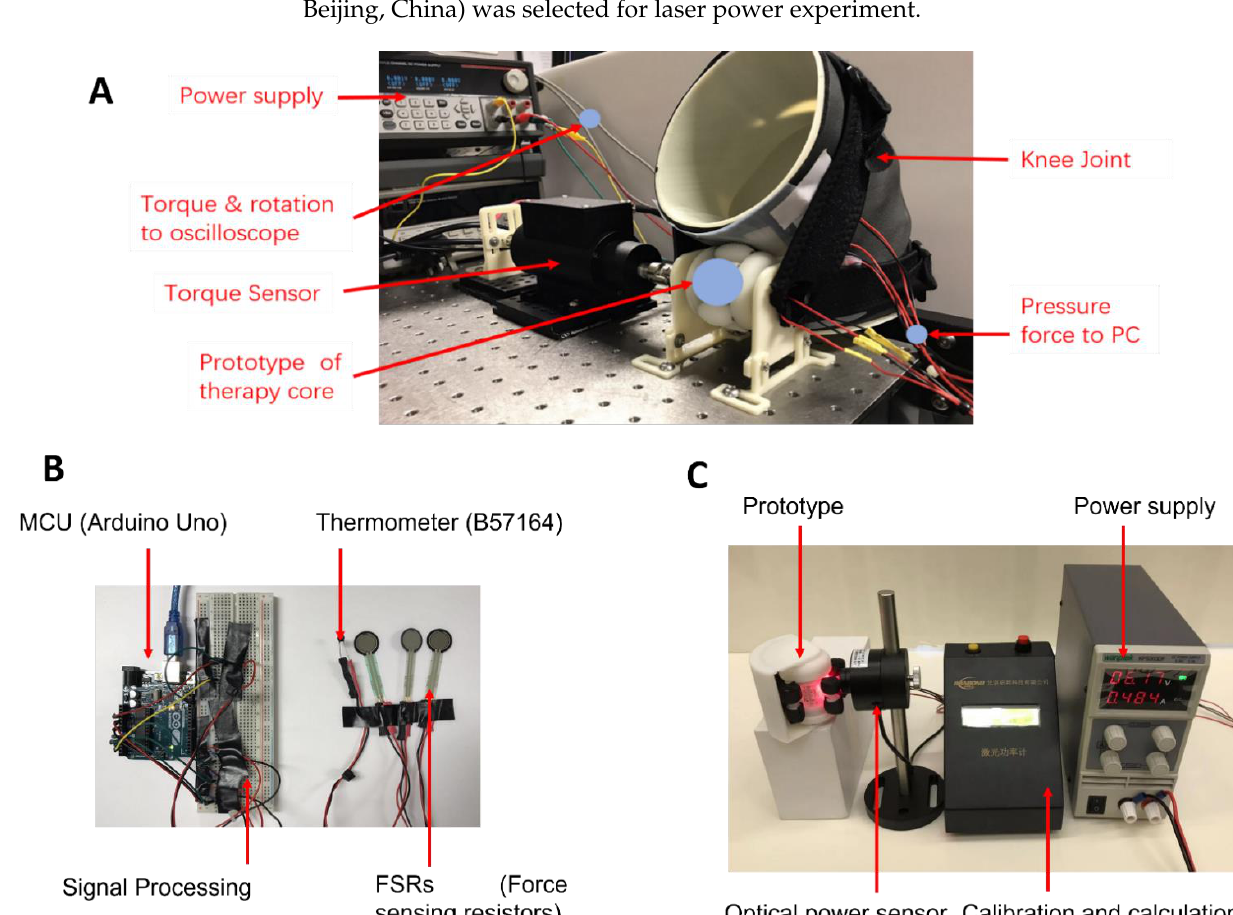
Figure 5. Experimental setup and the measurement system in the research laboratory. ( A ) Experi- mental bench setup of the hybrid therapeutic device used to test the massage therapy; ( B ) Prototype of the measurement system used to test the massage force and temperature; ( C ) Experimental bench setup of LLLT in the research laboratory.